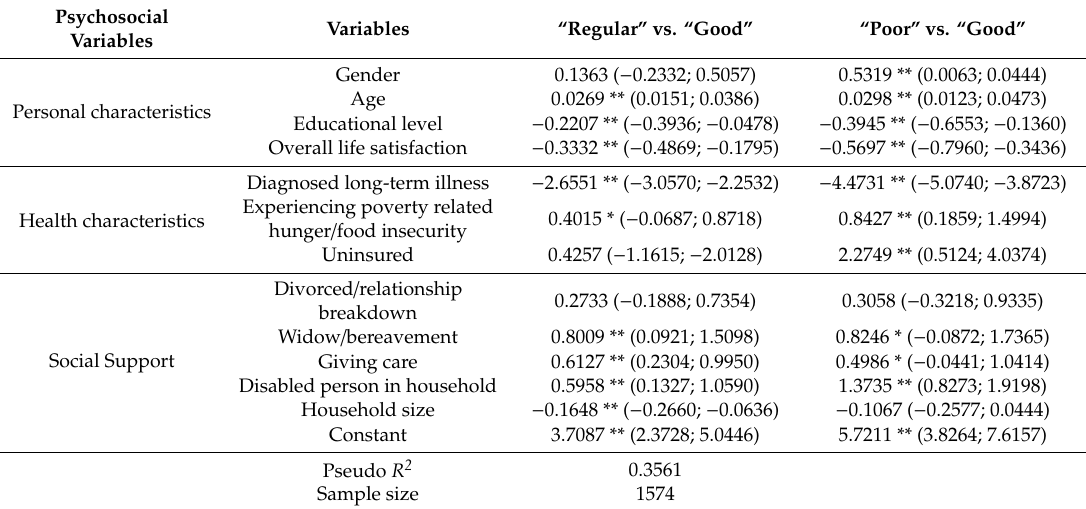
Table 2. Estimation of health status (“good” status fixed as base